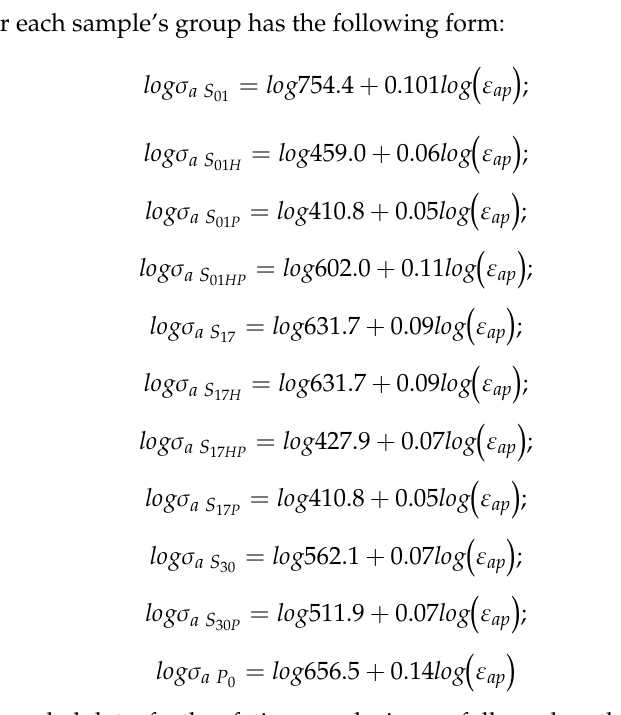
Figure 7. Stress amplitude versus plastic strain amplitude of as-built, heat-treated AM parts compared to conventionally made material stabilized hysteresis loops in log–log